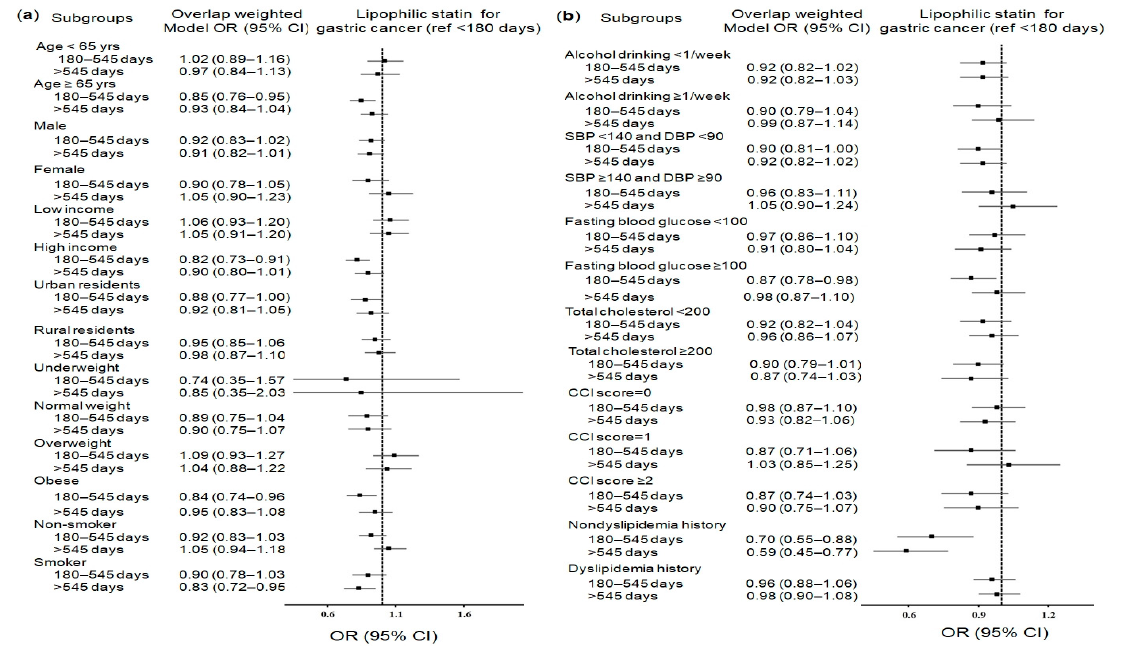
Figure 2. Forest plots for multivariable conditional logistic regression depicting the overlap weighted odds ratios (95% confidence intervals) of previous use duration of hydrophilic statins for incident gastric cancer according to comprehen- sive subgroup analyses, including age, sex, income, region of residence, obesity, and smoking ( a ), alcohol consumption, systolic blood pressure, diastolic blood pressure, fasting blood glucose, total cholesterol, CCI scores, and dyslipidemia history ( b ). The reference period is <180 days. Full results of the crude and adjusted overall weighted models are available in Supplementary Table S2 (hydrophilic statins).